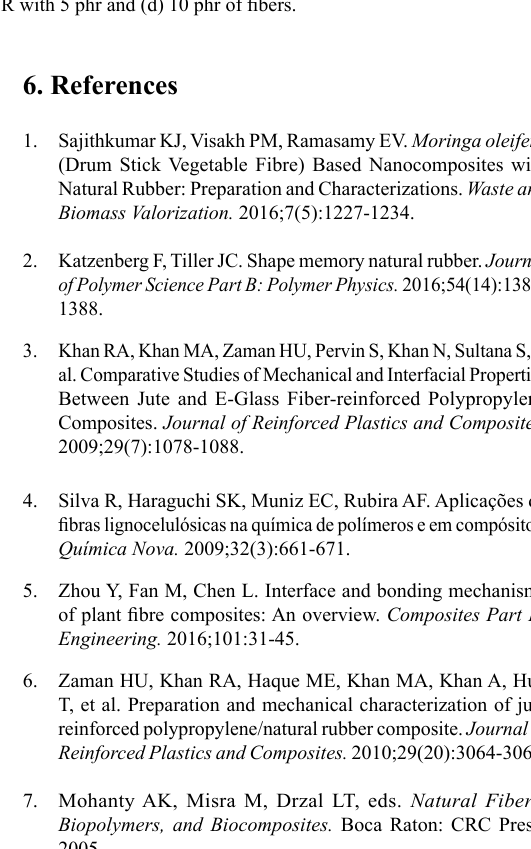
Figure 5. SEM images of: (a) NR, (b) NR with 2.5 phr, (c and e) NR with 5 phr and (d) 10 phr of